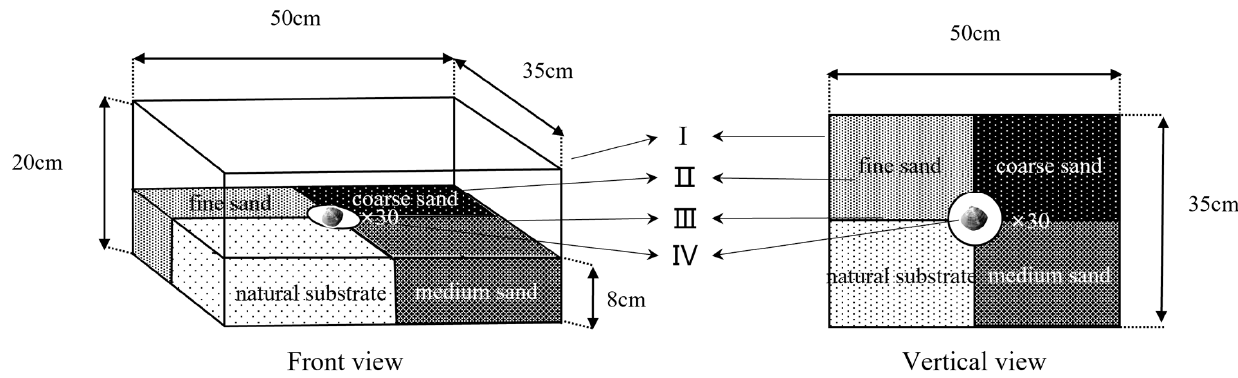
Figure 3. The device for the four substrate combinations. Unit I is the polyvinyl chloride sink, the four substrates (II) are separated by a partition (III), and a transparent plastic disc (IV), with a diameter of 8 cm and the same height as the substrate is fixed in the middle.